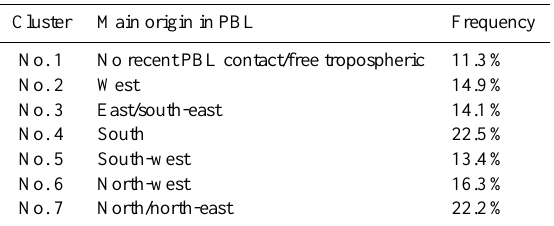
Table 2. Transport footprint clusters and main